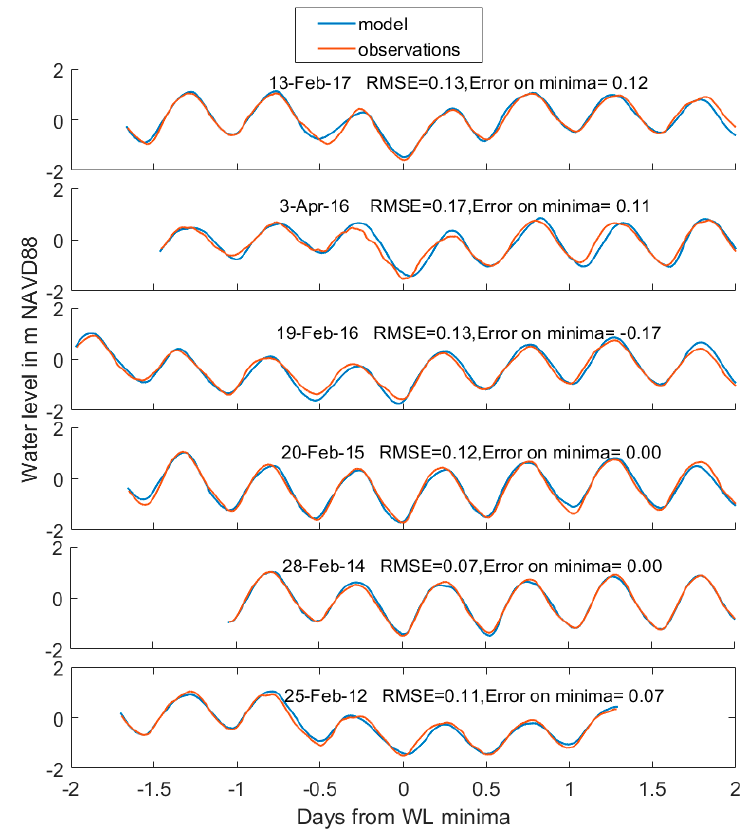
Figure 3. Hindcast simulations for six recent blowout events, showing water level at The Battery.